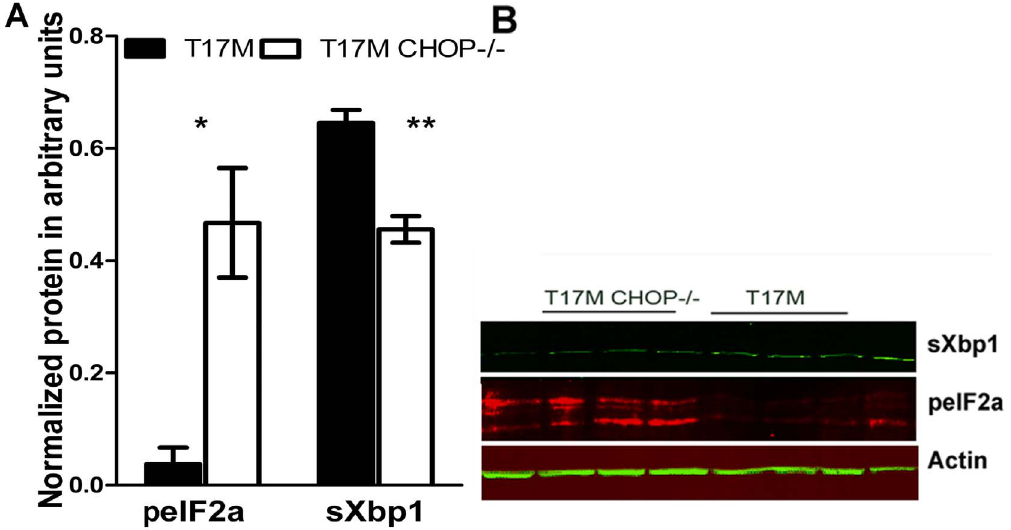
Figure 4. Ablation of CHOP protein in P30 T17M RHO retinas led to modulation of the PERK and IRE1 pathways of the UPR. A: We analyzed T17M RHO and T17M RHO CHOP 2 / 2 retinas (N=4) and found that the expression of phosphorylated eIF2 a protein was increased by over 8 fold in T17M RHO CHOP 2 / 2 mice (0.5 6 0.1 a.u.vs. 0.04 6 0.1 a.u., P =0.01). The level of spliced Xbp1 in the T17M RHO retina was decreased by 30%, presenting a value of 0.64 6 0.027 a.u. vs. 0.4 6 0.03 a.u.in T17M RHO CHOP 2 / 2 mice ( P =0.004). B: Representative images of western blots treated with antibodies against Xbp1, peIF2 a and b -actin proteins.